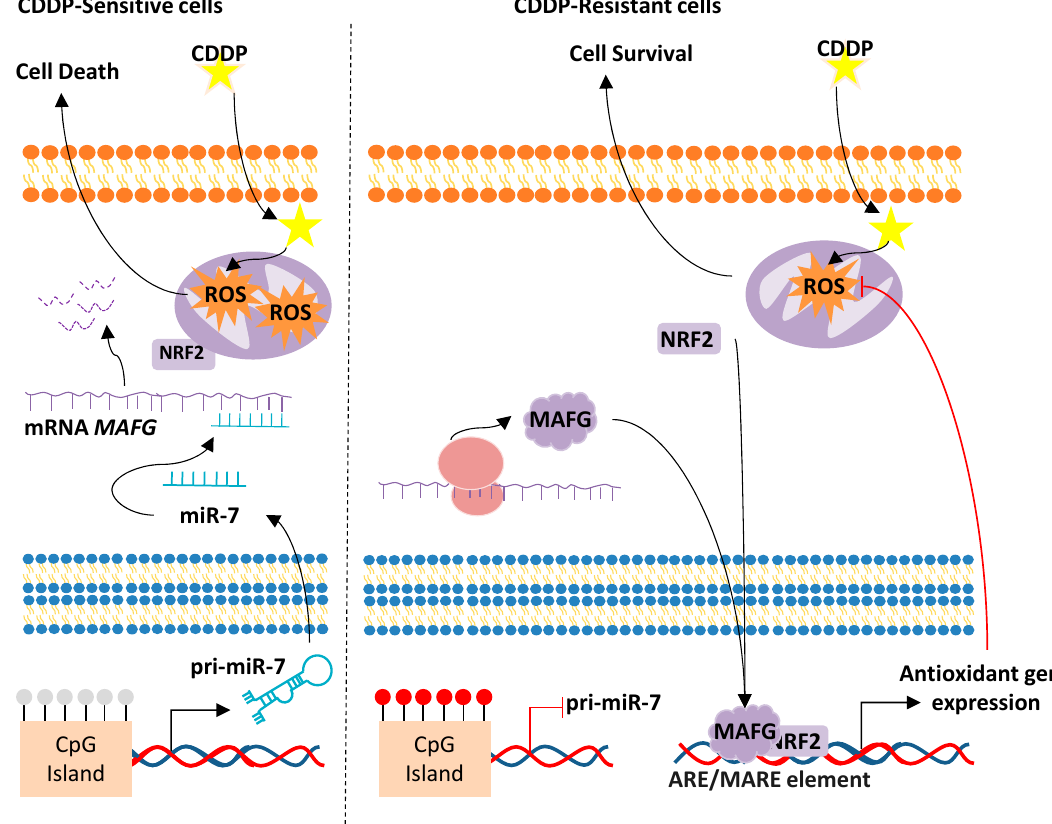
Figure 3. Proposed mechanism for the acquired resistance to cisplatin in NSCLC and ovarian cancer cells through miR-7 methylation and Musculoaponeurotic Fibrosarcoma Oncogene Family, protein G (MAFG) overexpression. Sensitive cells are represented on the left. The unmethylation of the miR-7 CpG Island allows its transcription, thus targeting the mRNA of MAFG, which promotes an increase of ROS and cell death. Cisplatin-resistant cells, right, harbor a methylated CpG island of miR-7, therefore allowing MAFG translation into protein, interaction with NRF2, and the transcription of antioxidant genes. CDDP, cisplatin; ROS, Reactive Oxygen Species.